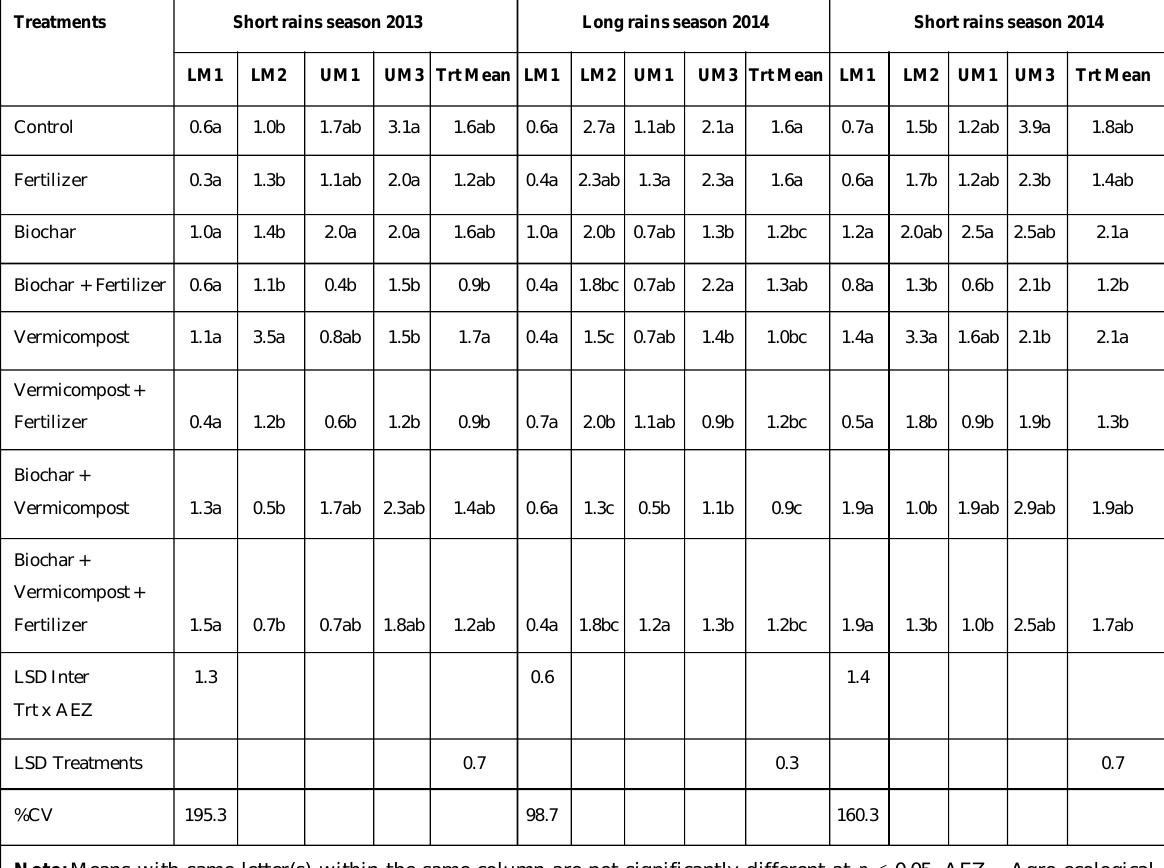
Table 5: Effect of different treatments on incidence (%) of bean root rot at two weeks of plant growth in different AEZ’s of Western Kenya